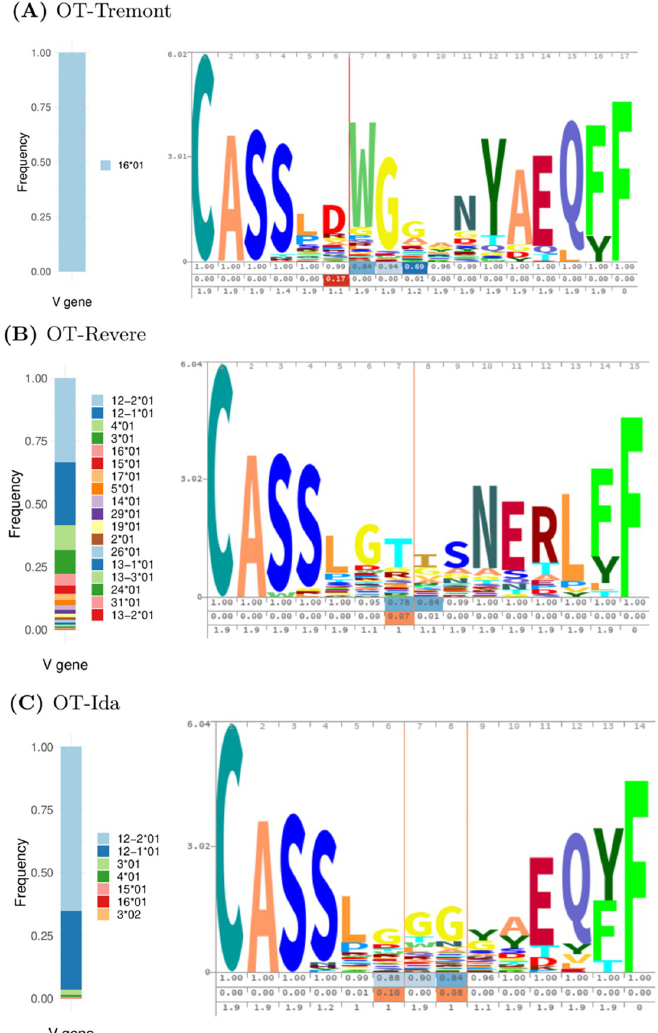
Fig 4. Visualizations of TRBV gene frequency statistics and CDR3aa sequence logos for the top three lonely clusters of the combined repertoire analysis: (A) OT-Tremont, (B) OT-Revere, (C) OT-Ida. The height of each stack within the sequence logo is proportional to the level of that position’s conservation, and the height of each amino acid is proportional to that amino acid’s frequency in that position. The rows below each sequence logo display the occupancies, insertion probabilities, and expected insertion lengths of the respective